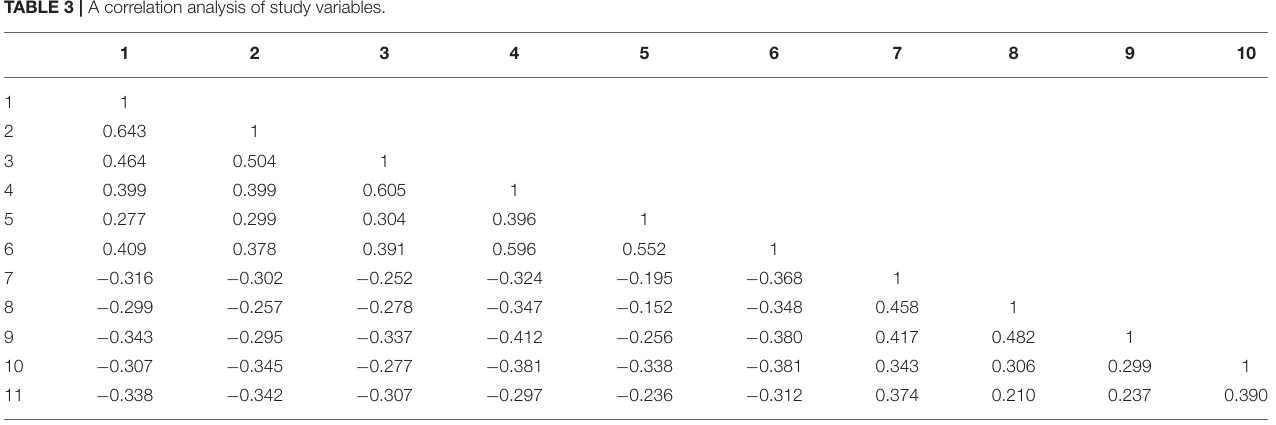
TABLE 3 | A correlation analysis of study variables.